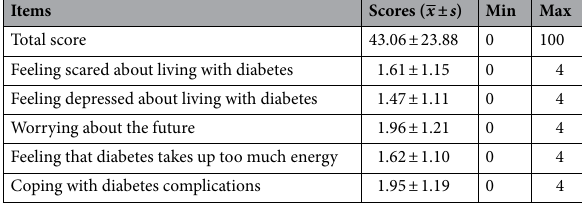
Table 4. PAID-5 scores.